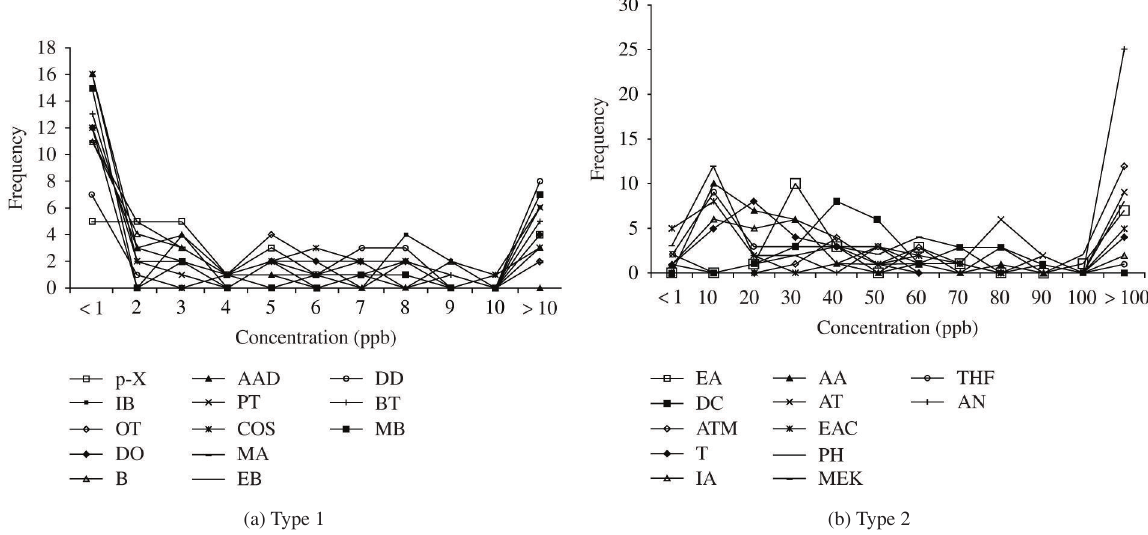
FIGURE 2: Frequency distribution of VOCs found in used Tedlar bags. (Compounds are grouped by their relative frequency: refer to Table 1 for acronyms of the